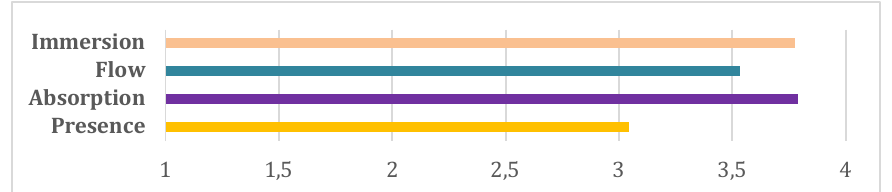
Fig. 5. Game engagement in new secondary school pupils.